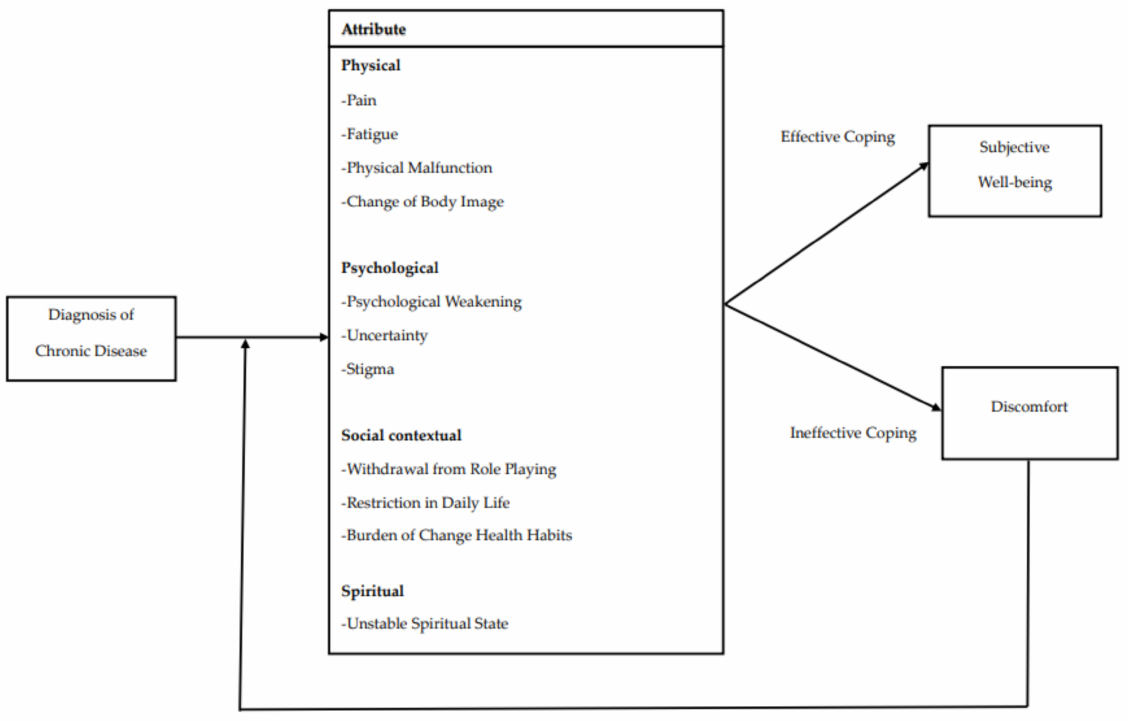
Figure 2. Conceptual model of illness intrusiveness for chronic